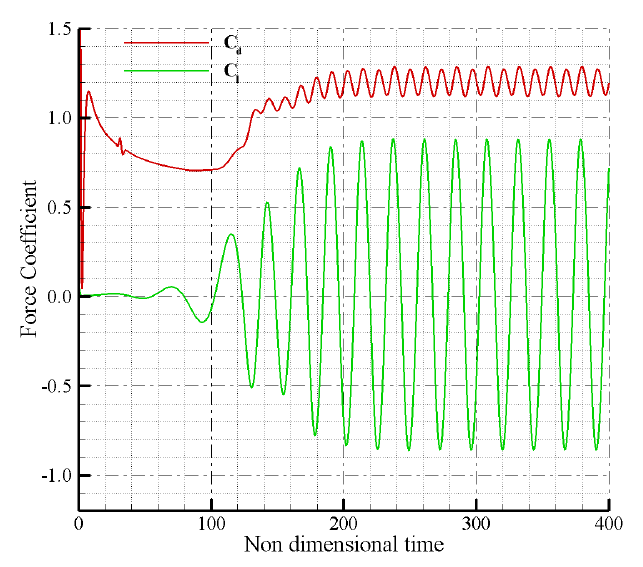
Figure 12. Fluctuating force coefficients for laminar flow past a 2D